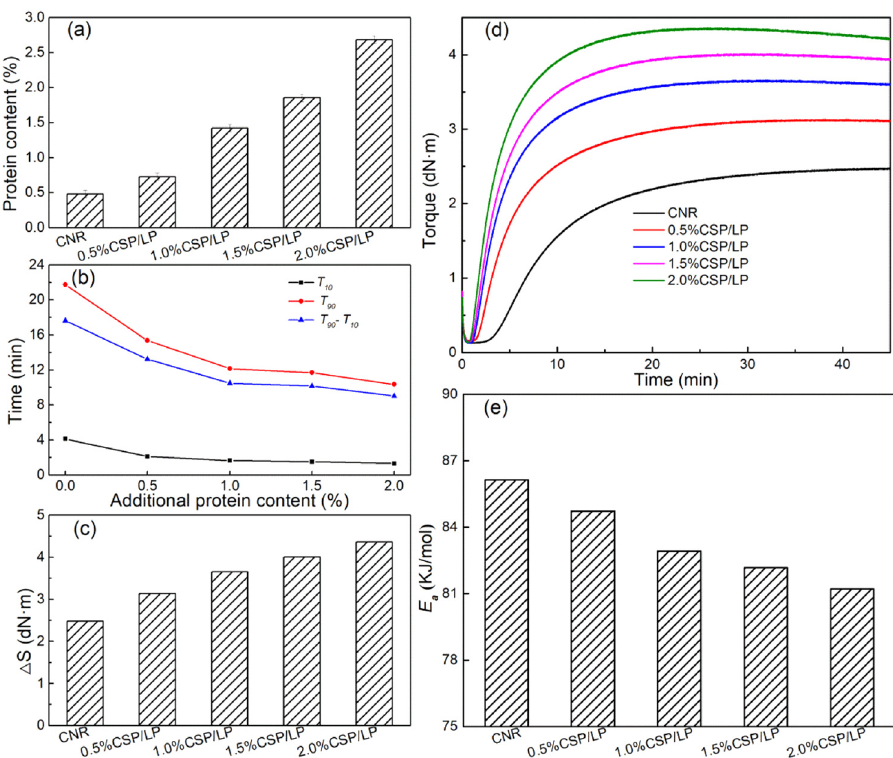
Figure 2: ( a ) NR protein content with CSP/LP addition; ( b ) vulcanization characteristic time of NR with di ff erent CSP/LP contents; ( c ) NR torque values of CSP/LP; ( d ) vulcanization curves of NR with di ff erent contents of CSP/LP; ( e ) E a of CNR and y % CSP/LP during the vulcanization induction period ( y is the proportion of CSP/LP )